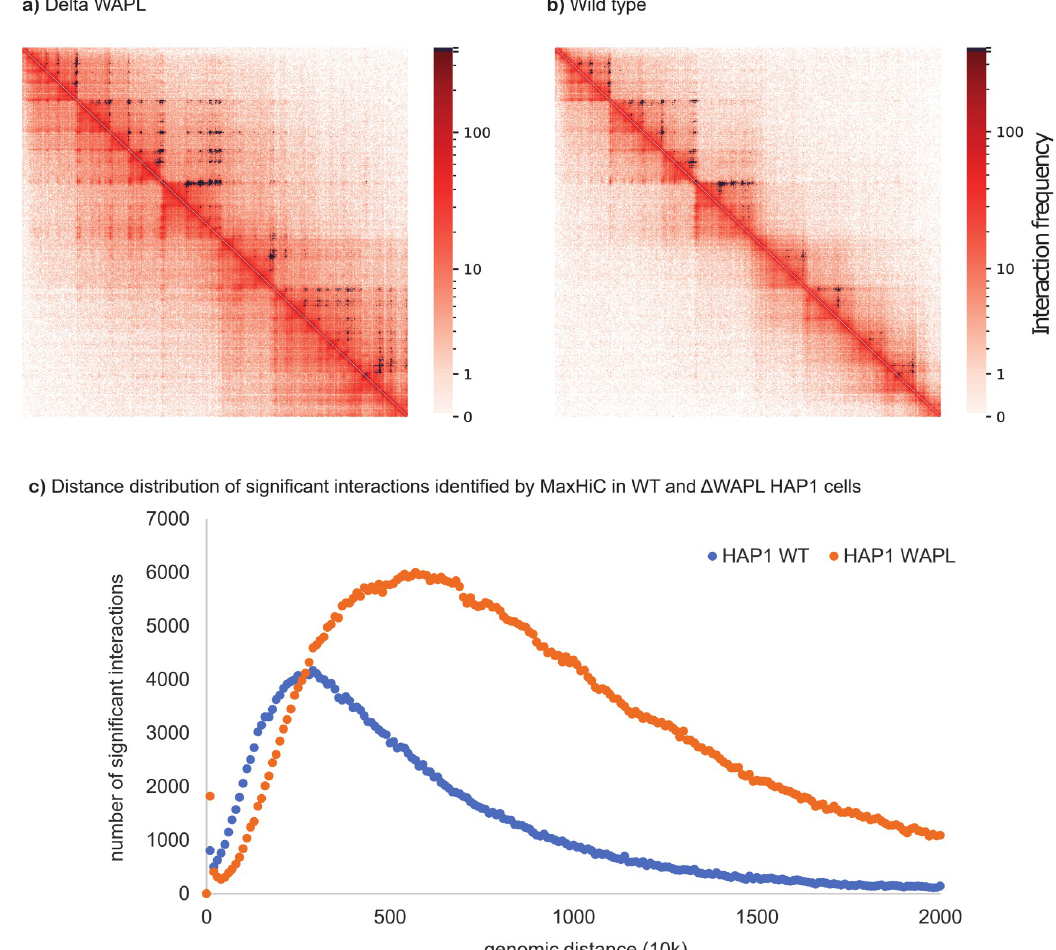
Fig 6. WAPL restricts chromatin loop extension. HiC Contact map comparing significant interactions identified in WT ( a ) and Δ WAPL HAP1 ( b ) cells at 10kb fragment size. Black pixels are significant interactions identified by MaxHiC at P-value < 0.001. (chr7: 25M-31M). c) Distance distribution of significant interactions identified by MaxHiC (P-value < 0.001, 10kb bins) in WT and Δ WAPL HAP1 cells. The number of significant interactions identified in HAP1 WT is 283,028 and the number of significant interactions identified in HAP1 WAPL is